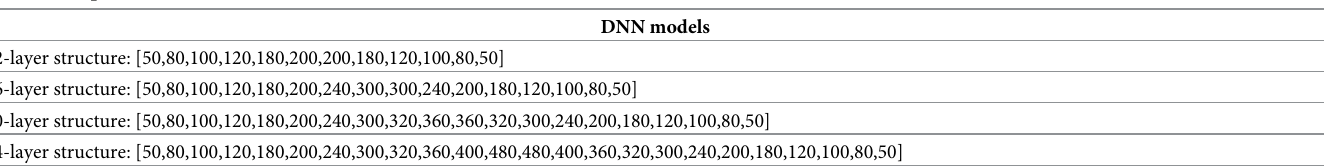
Table 2. Deep neural network models with labels.